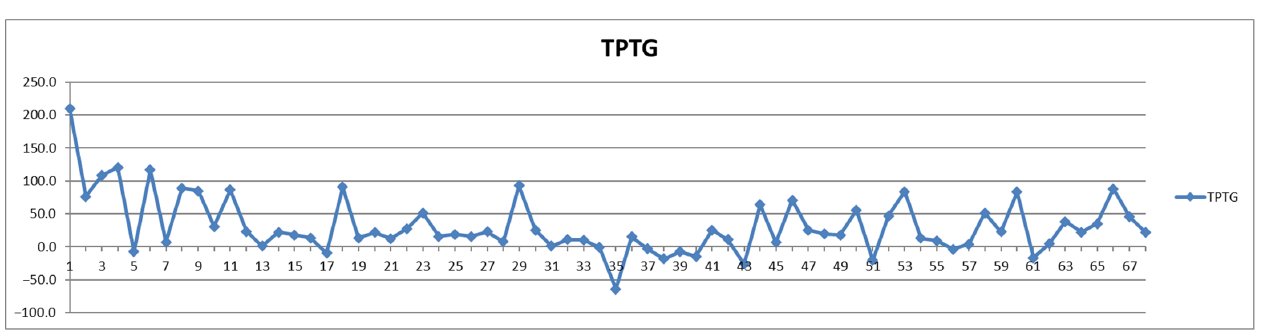
Figure 12. The food intake effect on LDL/HDL cholesterol ratios as difference between postprandial and fasting concentrations as percentage relative to fasting concentration.